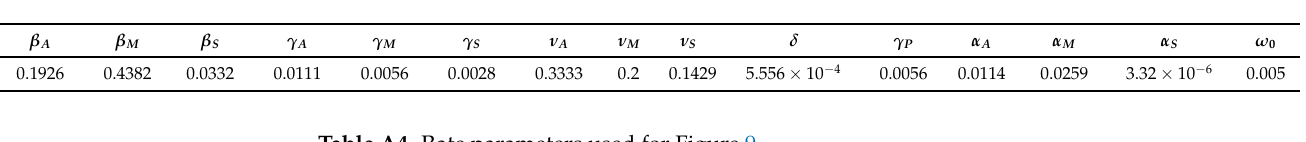
Table A4. Rate parameters used for Figure